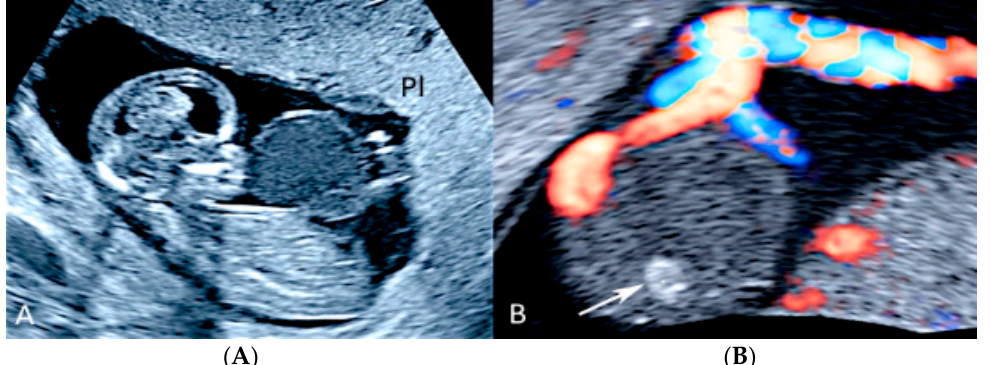
Figure 29. Pregnancy at 12 week’s gestation. Two-dimensional ultrasound: sagittal scan of the fetus showing a cyst filled with finely corpuscular material at the level of the cord insertion on fetal abdomen ( A ) . Color Doppler ultrasound highlights the cord’s splayed vessels due to a hemorrhagic cyst with a clot inside it (arrow) ( B ). (Legend: Pl: placenta )